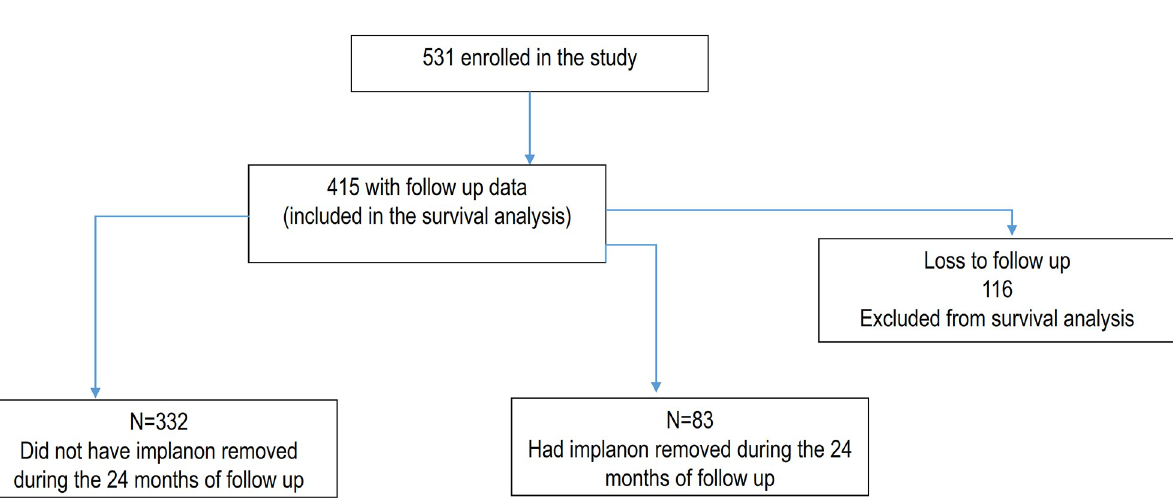
PLOS ONE | https://doi.org/10.1371/journal.pone.0232582 May 11,